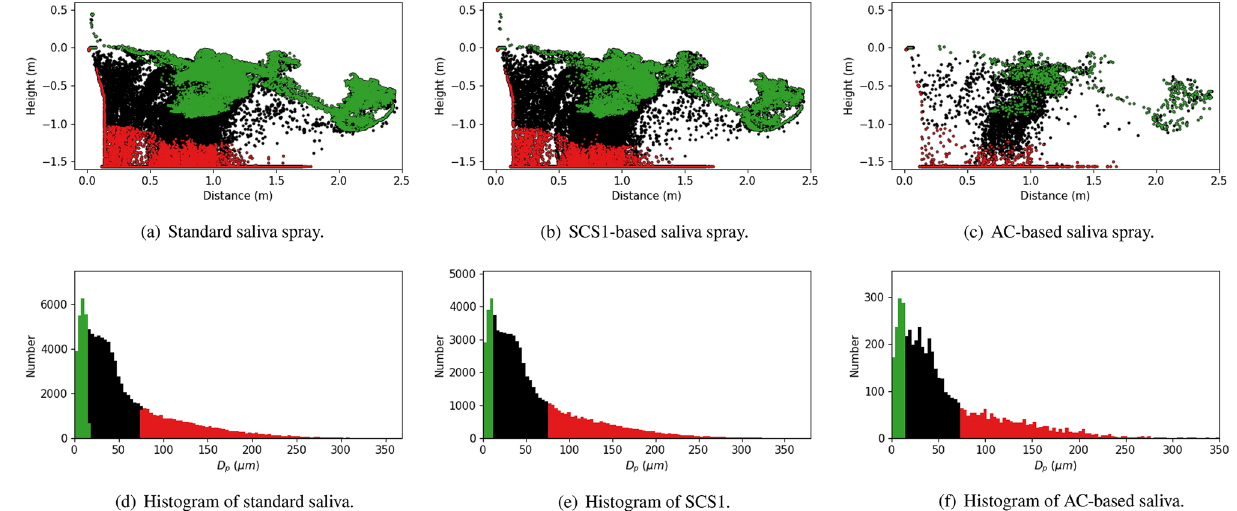
Figure 4. CFD simulations for different liquid droplet properties at 5 s after the sneeze.